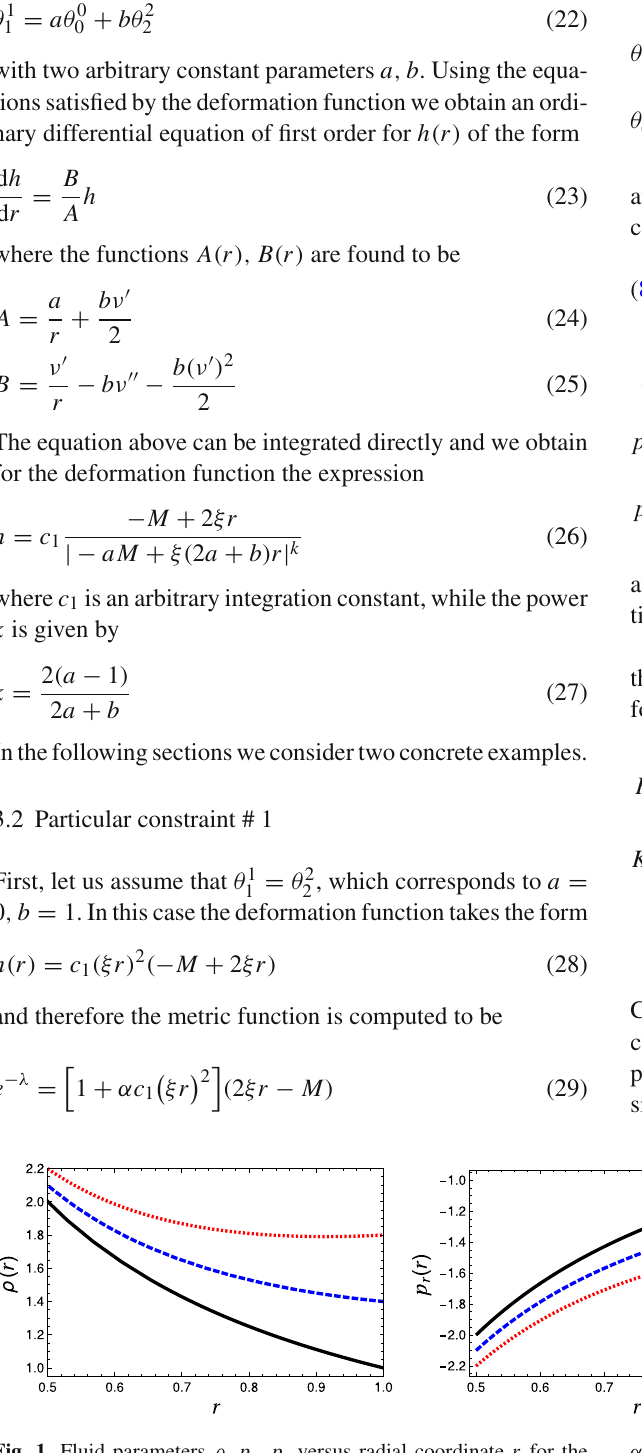
Fig. 1 Fluid parameters ρ, p r , p t versus radial coordinate r for the particular constraint # 1. Left panel: Energy density ρ vs radial coor- dinate r for different values of the parameter α . Middle panel: Radial pressure p r vs radial coordinate r for different values of the parameter